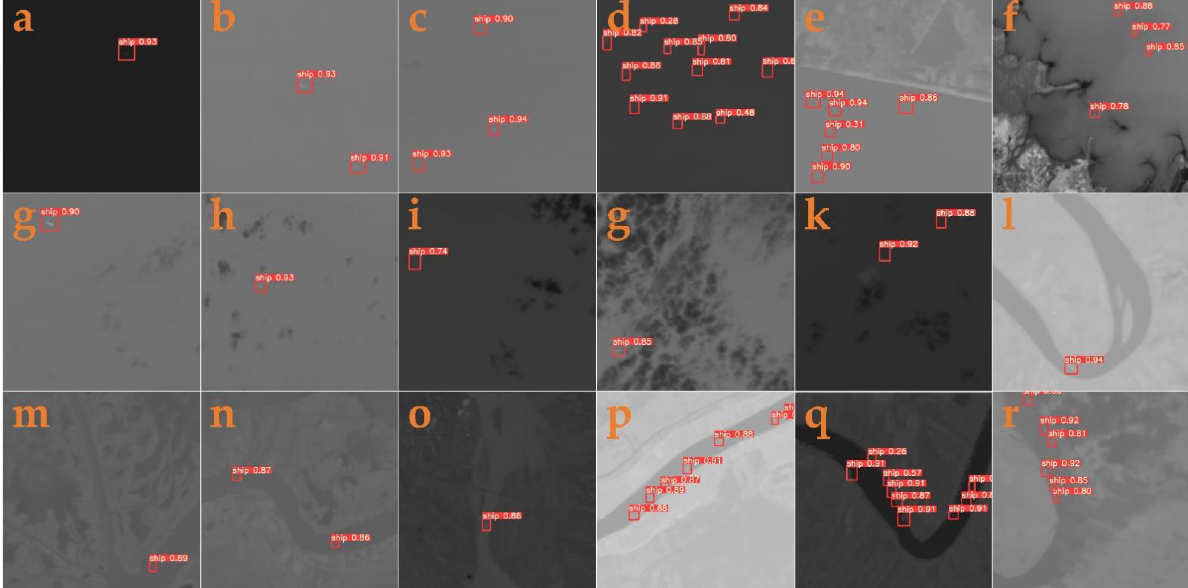
Figure 4. The predictions of the proposed method (CYSDM) in different scenes, including: ( a – d ) a calm sea, ( e , f ) a bay, ( g – k ) the sea under cloud cover, ( l – q ) a river, ( r ) a river under cloud